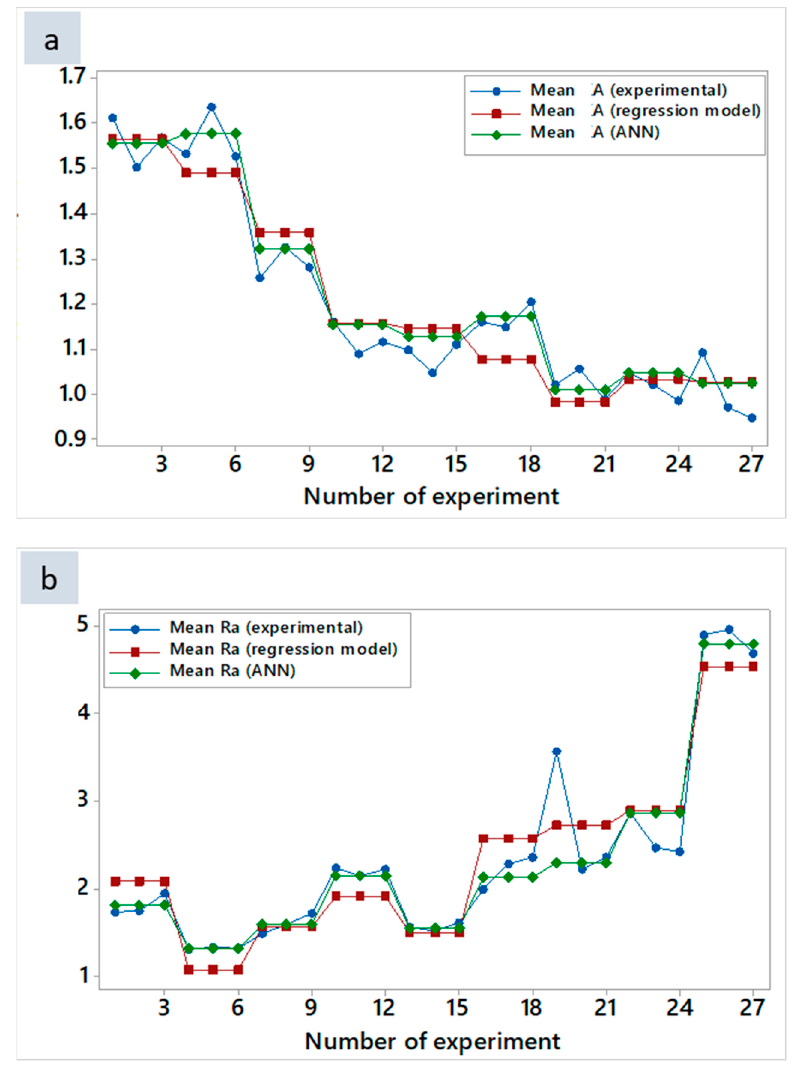
Figure 8. Comparison among experimental results, regression model, and ANN for ( a ) mean kerf angle and ( b ) mean surface roughness.